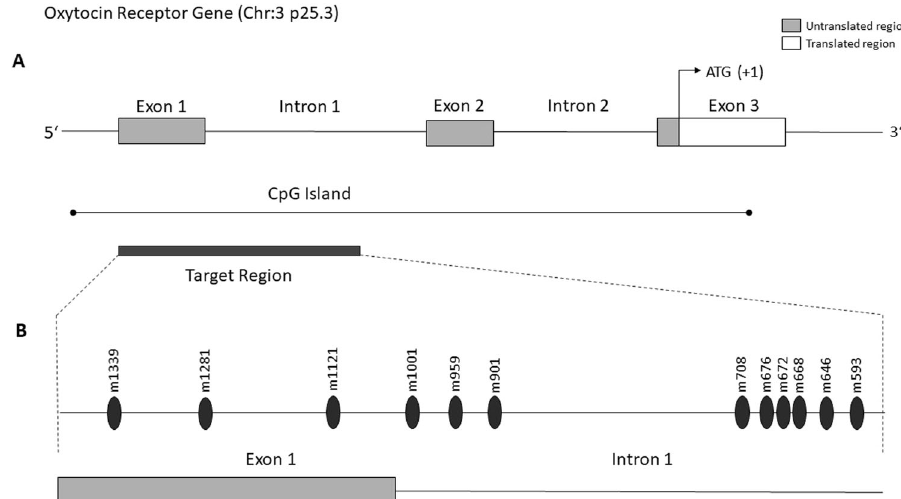
Fig. 1 Schematic view of the oxytocin receptor gene. A The protein-coding (translated) region of the OXTR gene is indicated in white, whereas the untranslated promotor region is indicated in gray. The transcription start site lies within the third exon of the gene, as indicated by the nucleotides ATG. B The region observed in our study (target region) is located within the fi rst exon and the fi rst intron of the OXTR gene. The position of CpGs is given relative to the transcription start site (example: CpG m1339 is located 1339 nucleotides upstream (5') of the transcription start site). Only CpGs where signi fi cant group differences could be detected are shown in this fi